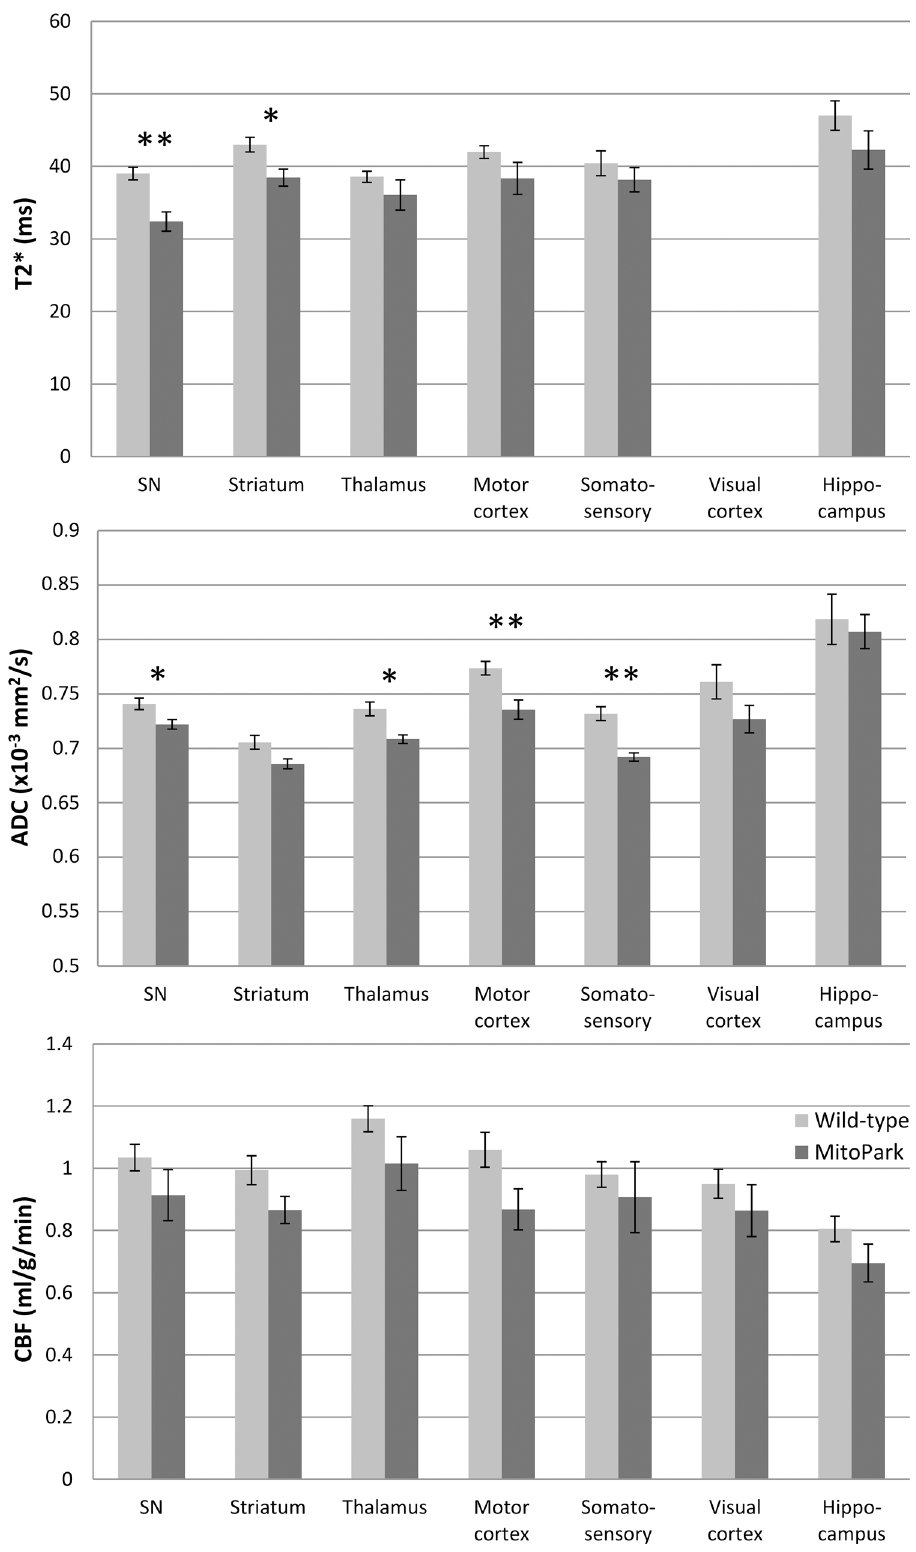
Fig 3. T2 * , apparent diffusion coefficient (ADC), and cerebral blood flow (CBF) of the wild-type and MitoPark groups. Mean ± SEM. * p < 0.05; ** p < 0.005 significant differences vs. age-matched